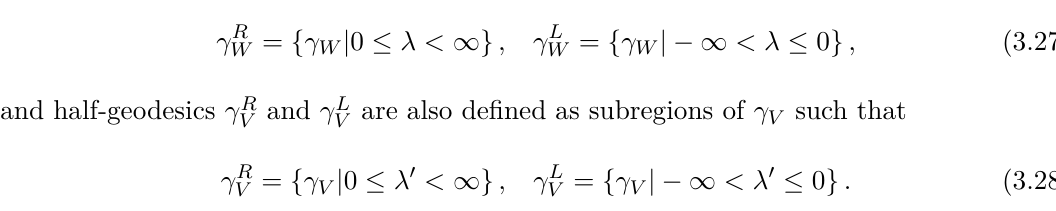
Figure 4 . Geodesics ( γ W , γ V ) and half-geodesics ( γ R as dashed